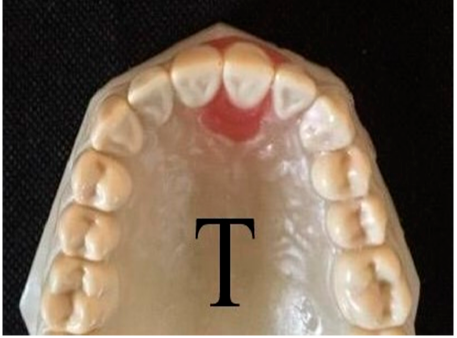
Figure 1. A custom ‐ made typodont upper arch model with a movable left central incisor (Model T). Table 1. A list of models and scans used in the study.